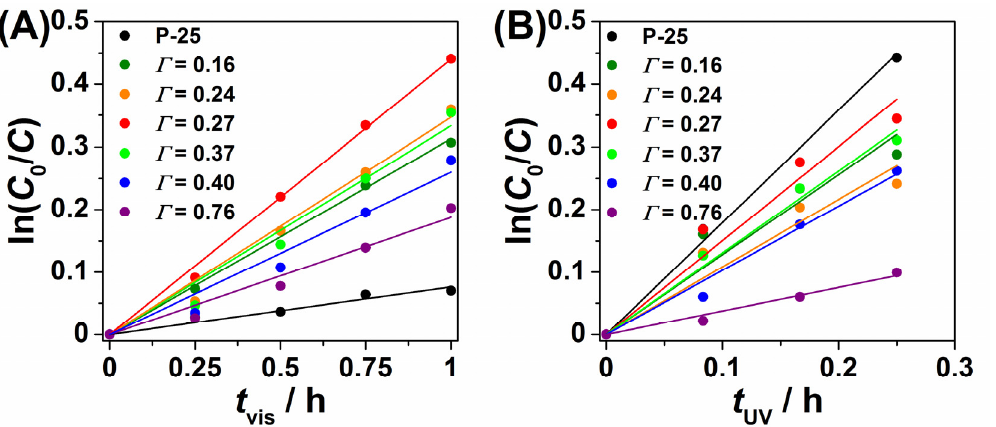
/ C ) versus irradiation time ( t ) for the 2-naphthol degradation under Figure 7. Plots of ln ( C 0 visible-light irradiation ( A ) and UV-light irradiation; ( B ) C concentrations at t = 0 and t = t , d d